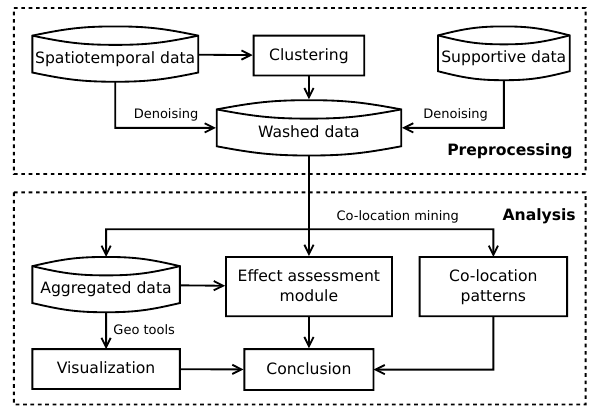
Figure 1. Workflow of